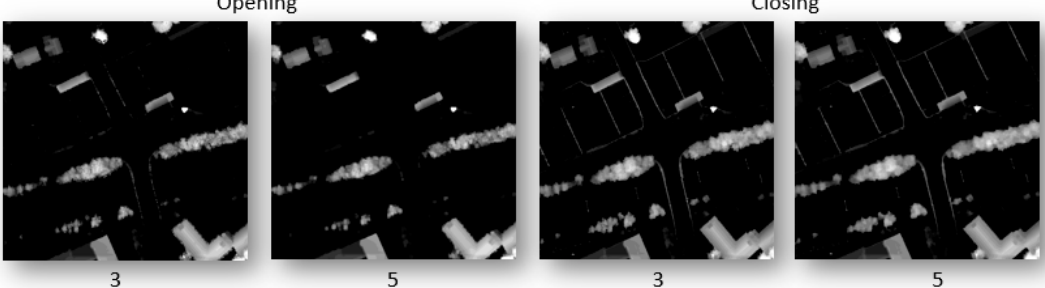
Figure 6. Opening and closing operations on lidar dataset with different kernel sizes (3 and 5) of the structural element.